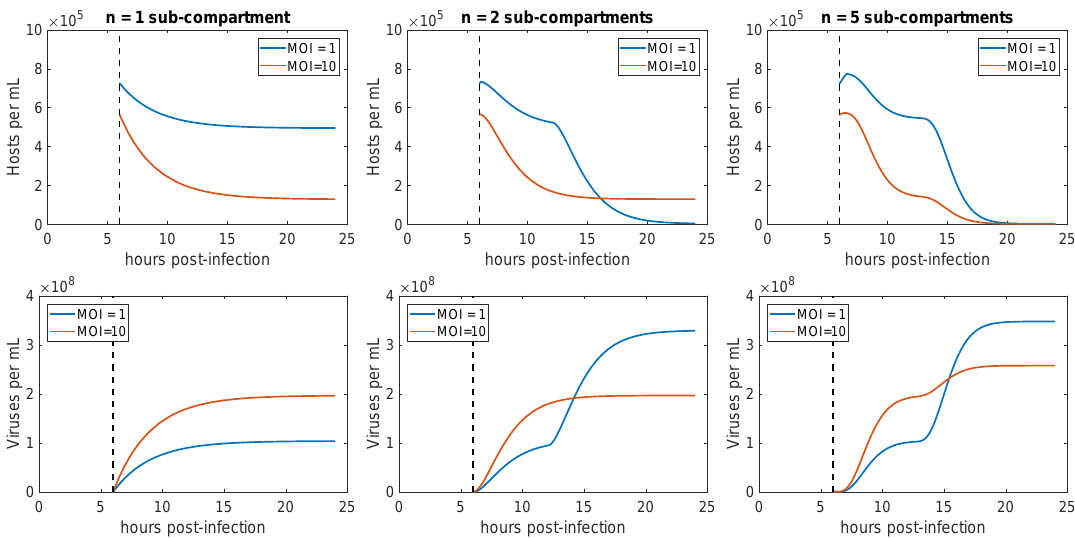
Figure 5. Simulated infection dynamics across different variation in latent period. ( Top Row ) Host dynamics for low and high MOI with (left) high variation in latent periods obtained using a single sub-compartment of infection, n = 1, (middle) moderate variation in latent periods obtained using two sub-compartments of infection, n = 2, and (right) low variation in latent periods obtained using five sub-compartments of infection, n = 5. ( Bottom Row ) Virus dynamics for low and high MOI with (left) high variation in latent periods obtained using a single sub-compartment of infection, n = 1, (middle) moderate variation in latent periods obtained using two sub-compartments of infection, n = 2, and (right) low variation in latent periods obtained using five sub-compartments of infection, n =